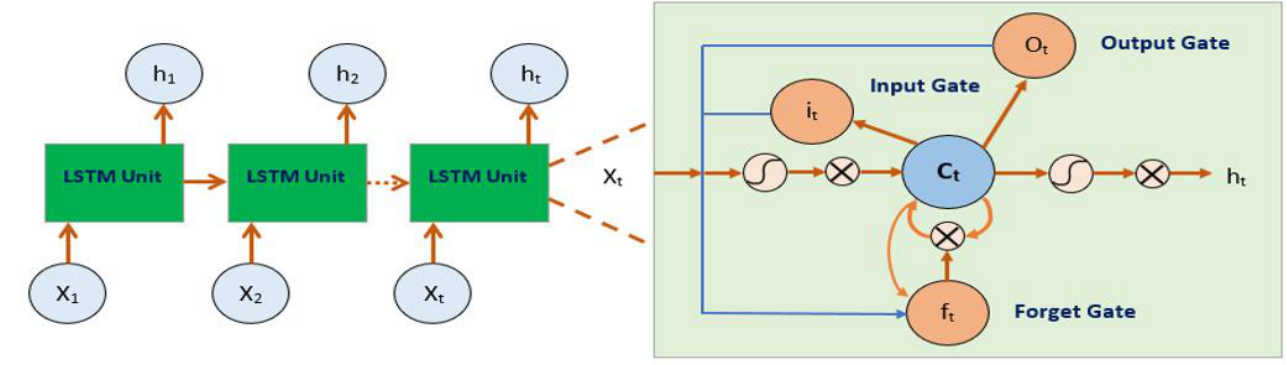
Figure 4. The basic structure of LSTM.